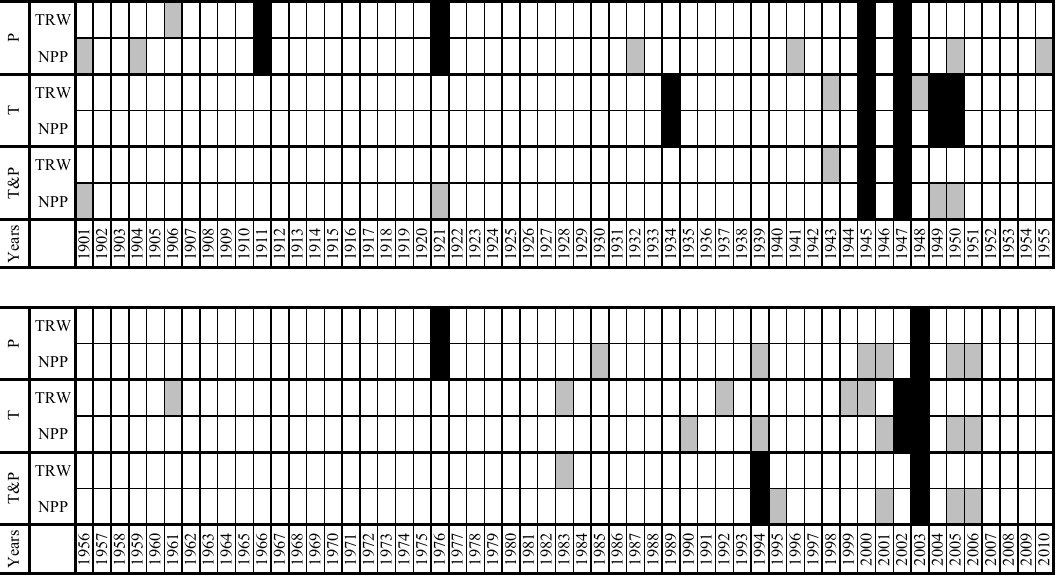
Figure 3. Extreme years during the period 1901–2010 as detected by the coincidence analysis for TRW and NPP (only at TRW sites) with precipitation (upper two rows), temperature (middle two rows) and combined precipitation and temperature (lower two rows) extremes. Black bars indicate that extreme years were detected in both TRW and in